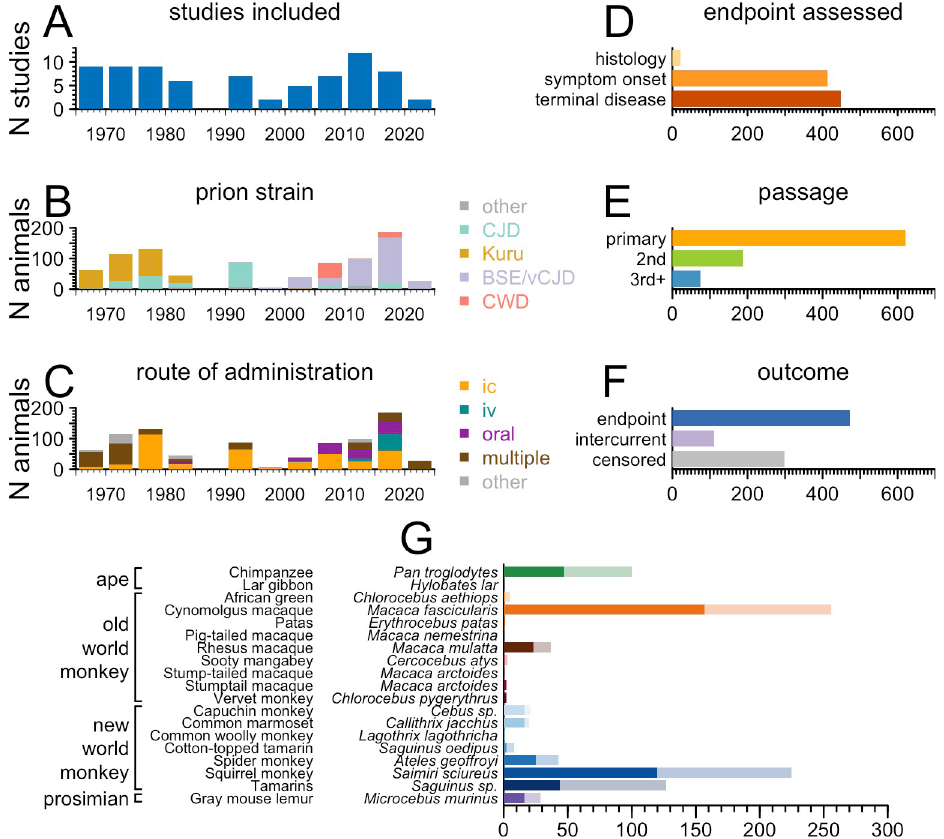
Fig 2. Overview of aggregated dataset of prion NHP experiments. Graphical summary of A) studies included in our analysis by year; B) prion strains studied by year; C) routes of prion administration employed, by year; and D) study endpoints, by number of NHPs. E) Passage number of the prion inoculum used, by number of NHPs. Primary refers to direct human brain isolates. Second and third+ passage refer to inocula originating from human brain tissue, that have been inoculated into NHPs, then harvested and re-inoculated into subsequent NHPs. F) The number of NHPs reaching the study’s endpoint, lost to intercurrent illness, and censored at the time of study completion. G) The number of prion-inoculated NHPs reported in the prion literature, by species. Dark bars represent animals that reached endpoint, while light bars show animals that were lost to intercurrent illness or censored.